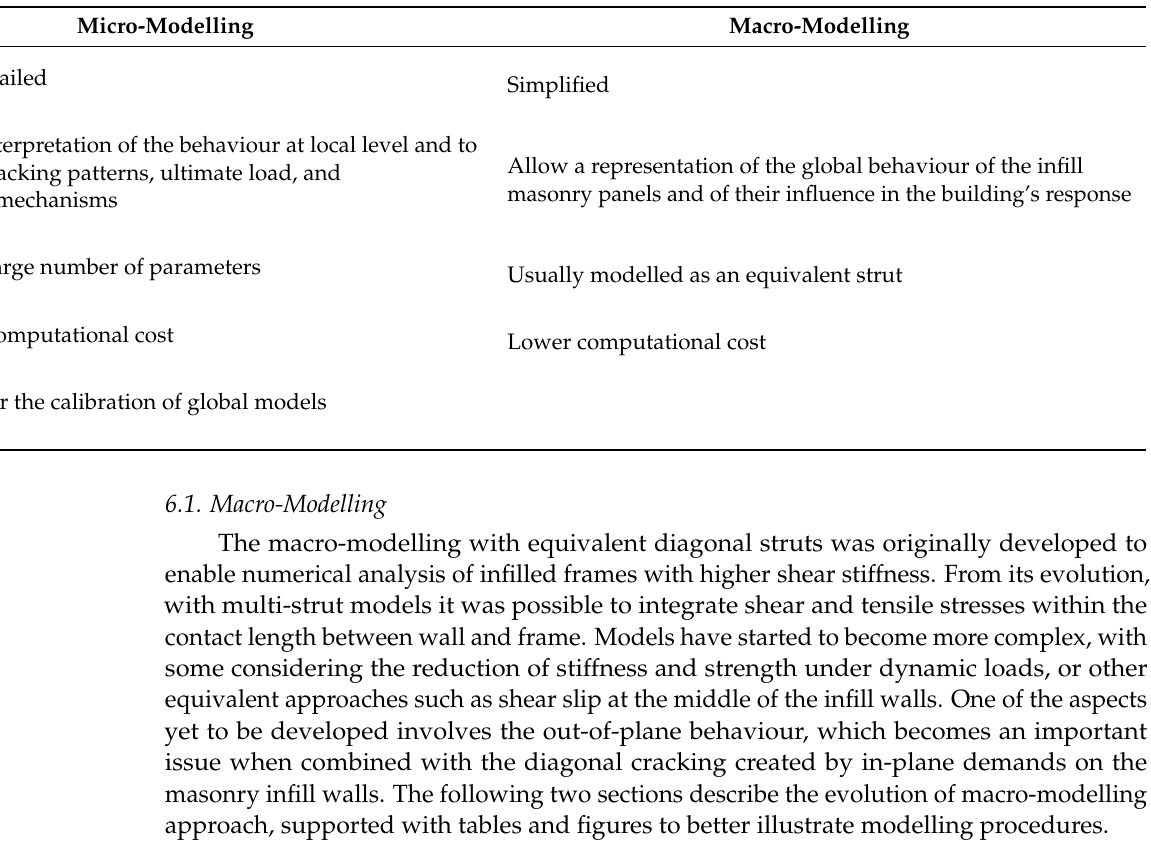
Table 6. Comparison between micro- and